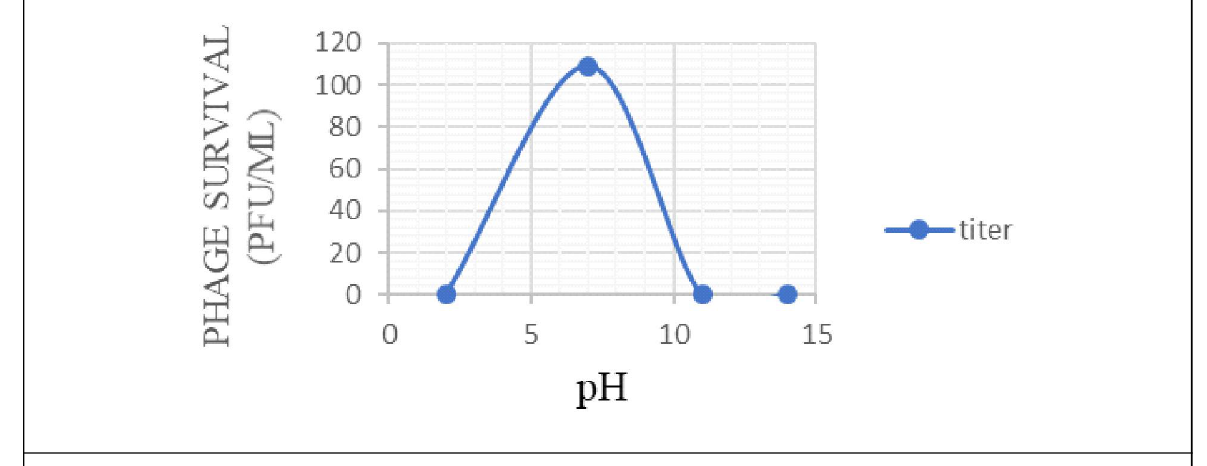
Figure 7: pH stability for PaMash phage